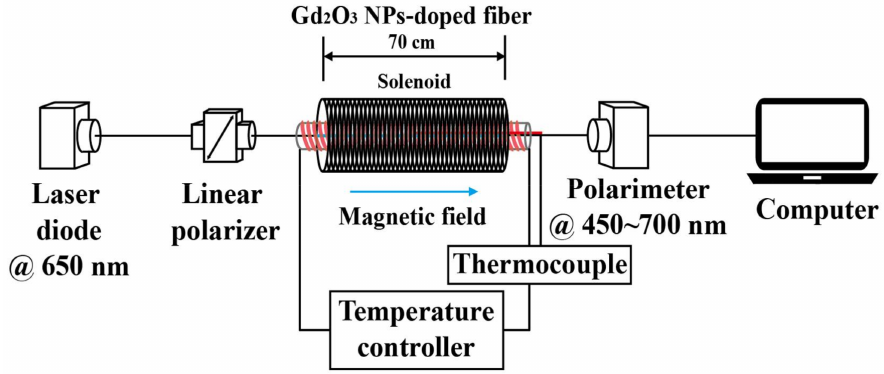
Figure 2. Experimental set-up to measure the temperature-dependent FRA of the Gd 2 O 3 NPs-doped fiber under magnetic field induced by the DC